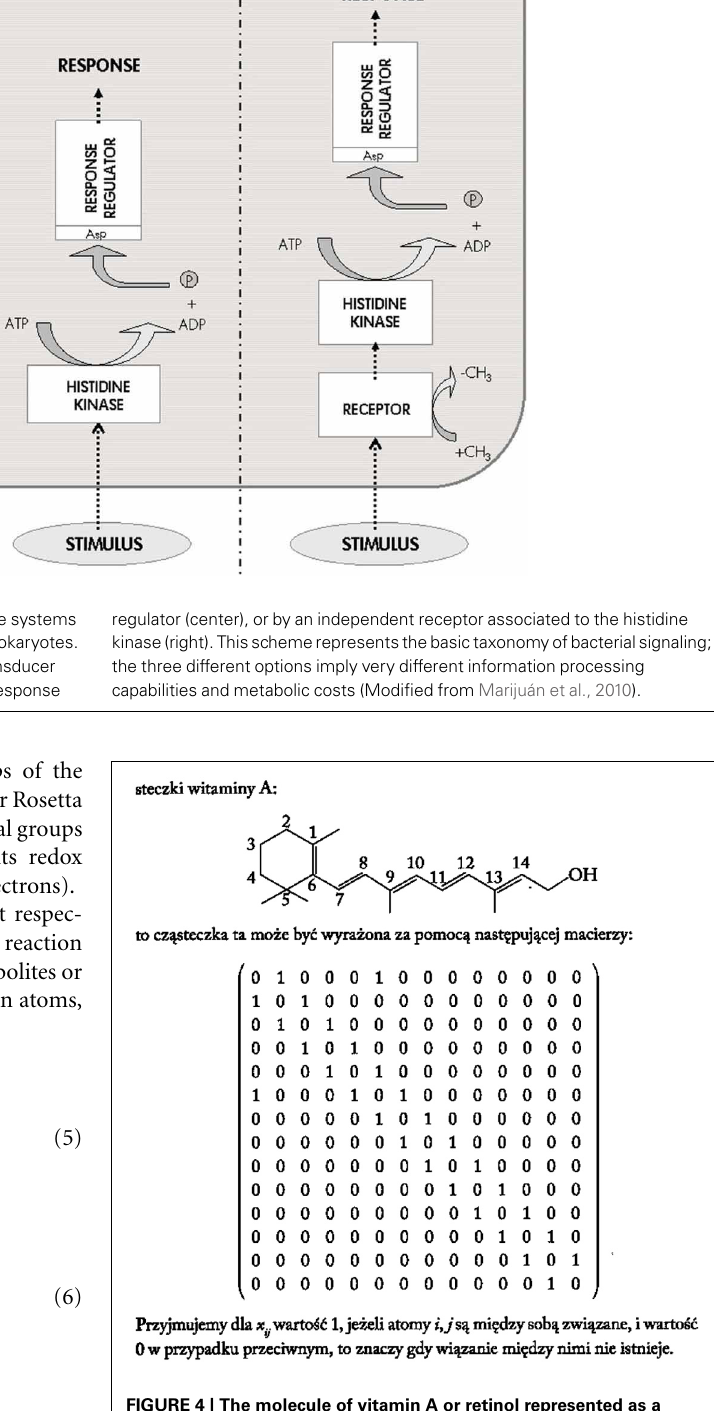
FIGURE 4 | The molecule of vitamin A or retinol represented as a binary matrix (Lahoz-Beltra, 2012a; Transl: